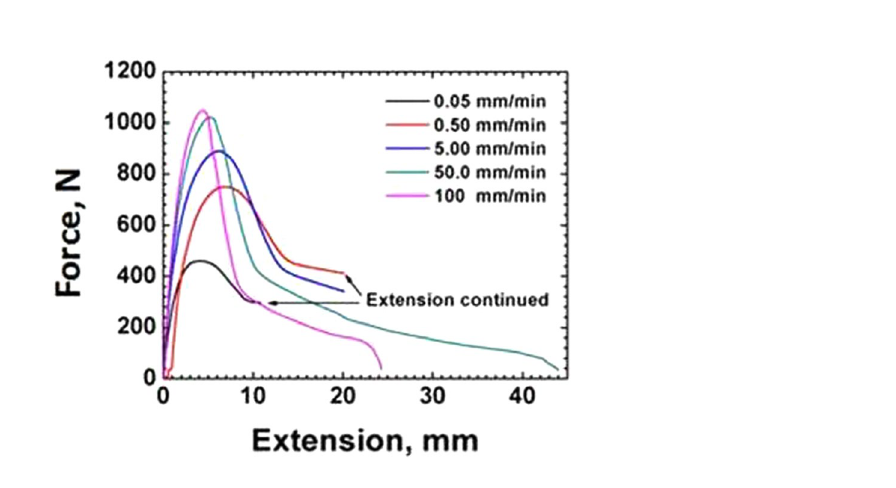
Figure 3. Load-extension curves of sharp crack HDPE at 25 C under various crosshead